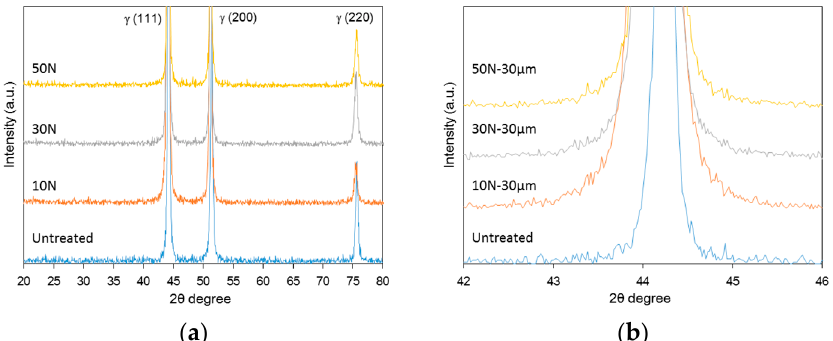
Figure 8. The effect of the static load in UNSM treatment on the XRD patterns of Alloy 600: ( a ) 20°– 80°; ( b ) 42°–45°.